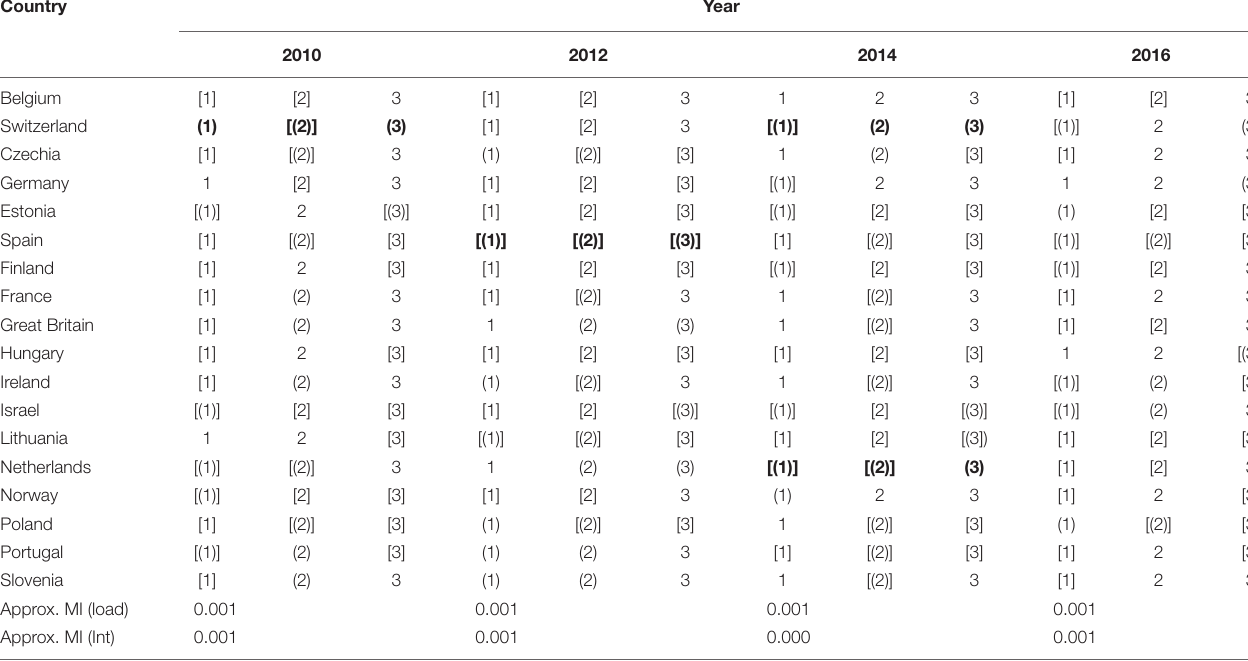
TABLE 3 | Opposition to migration index, between country invariance.